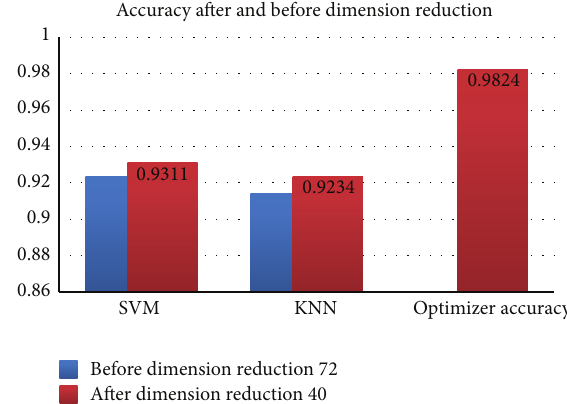
Figure 7: Different classifiers accuracy rate before and after data dimension